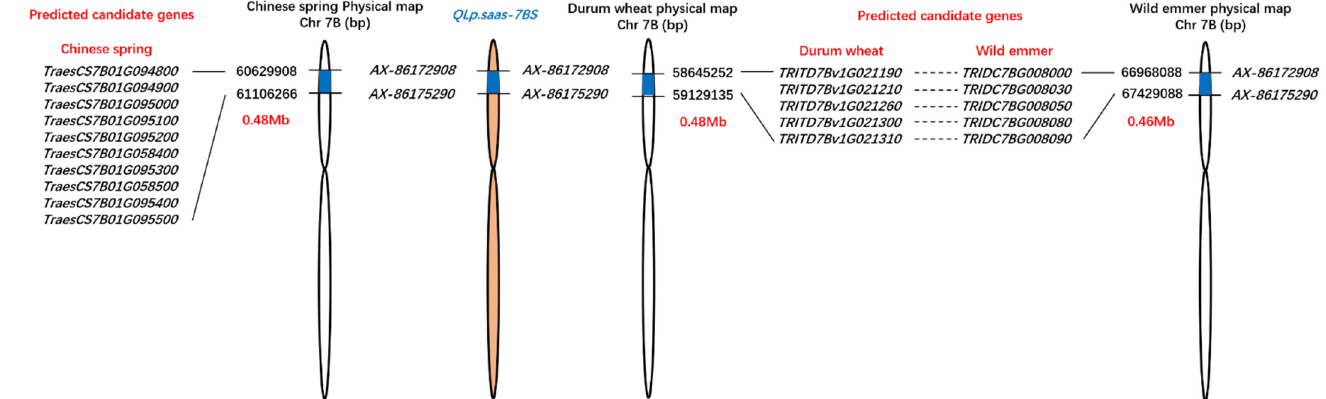
Figure 3. Physical map and candidate genes of the major-effect QTL QLp.saas-7BS in relation to the Chinese Spring, wild emmer, and durum wheat reference genome sequences accessed in the Triticeae Multi-omics Center database (http://202.194.139.32/).